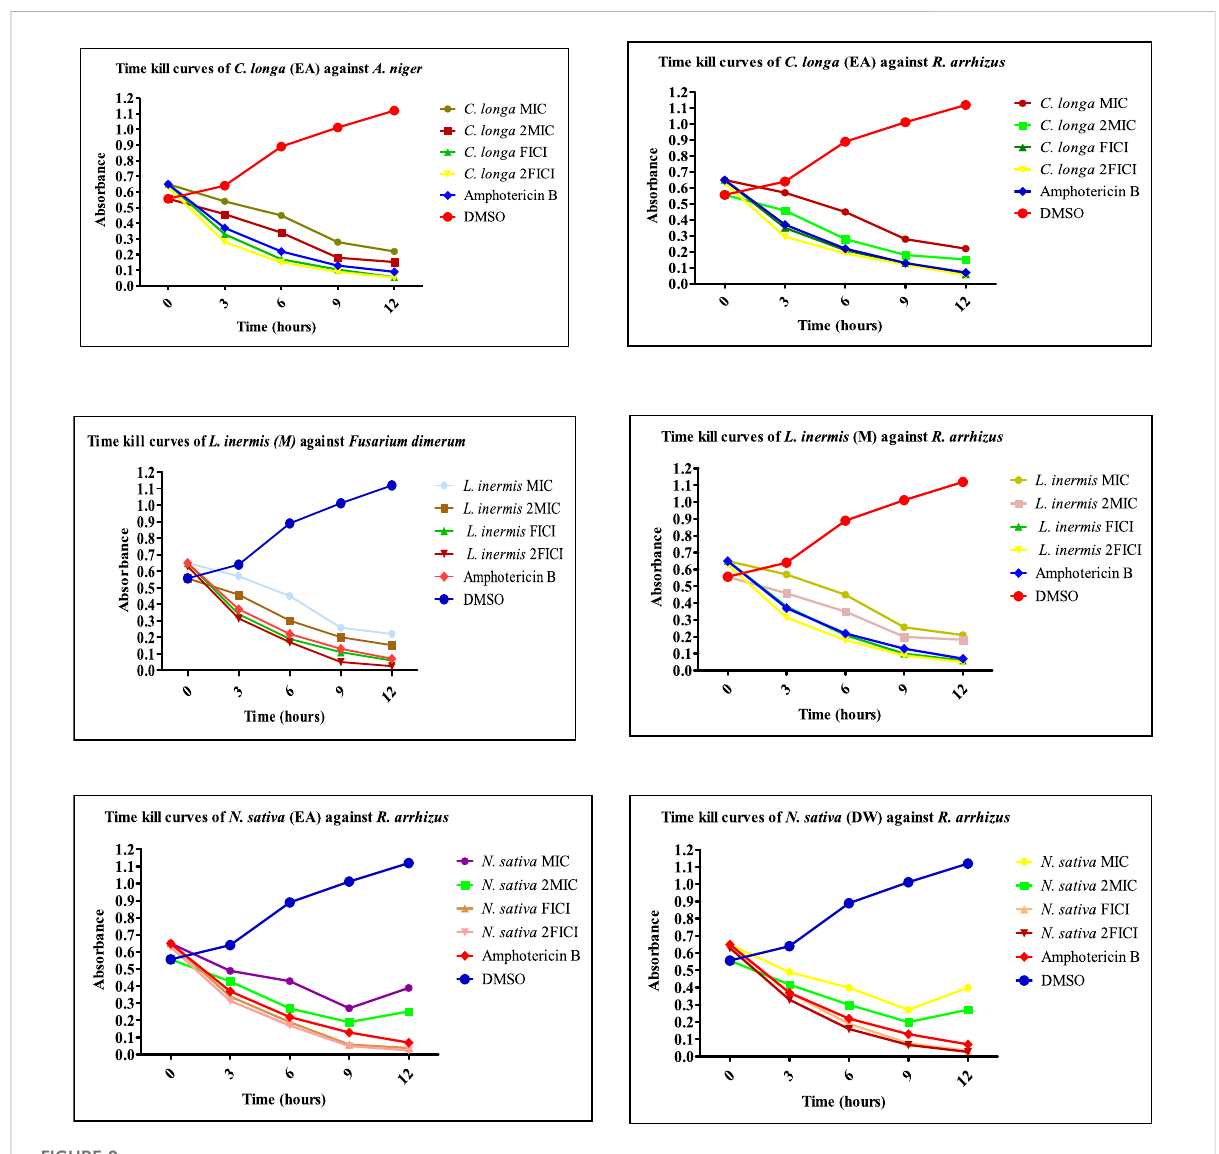
FIGURE 9 Time-kill curves of selected extracts against non-dermatophytes. EA, ethyl acetate extract; M, methanolic extract; DW, distilled water